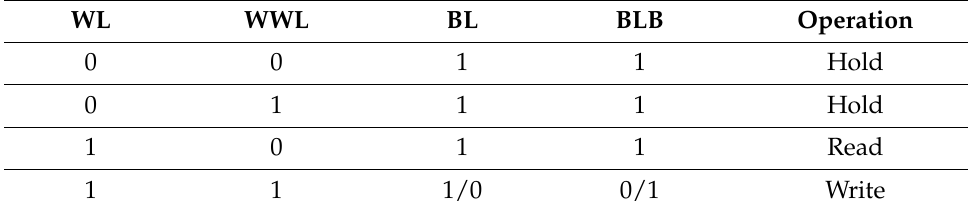
Figure 2. Proposed read stability aware 12T SRAM cell (RS12T). Table 1. Control signals of the SRAM